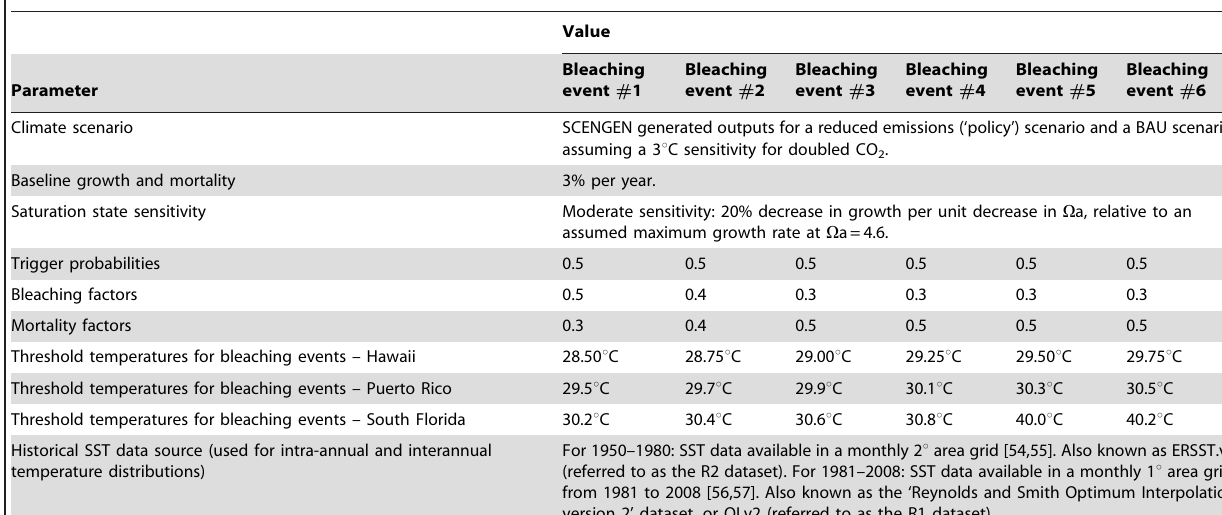
Table 1. Parameters used for modeling